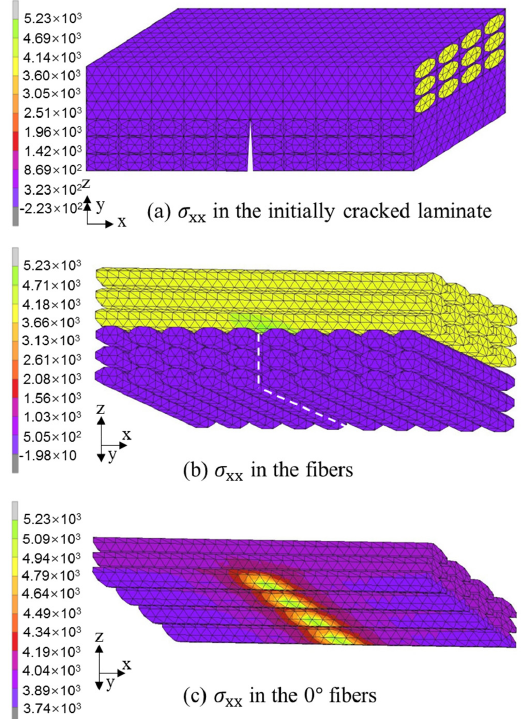
Figure 13. Tensile stress distribution in the [0/45]s laminate under failure stress obtained from the crack-free model: ( a ) σ xx in the laminate; ( b ) σ xx in the fibers; ( c ) σ xx in the 0° fibers.